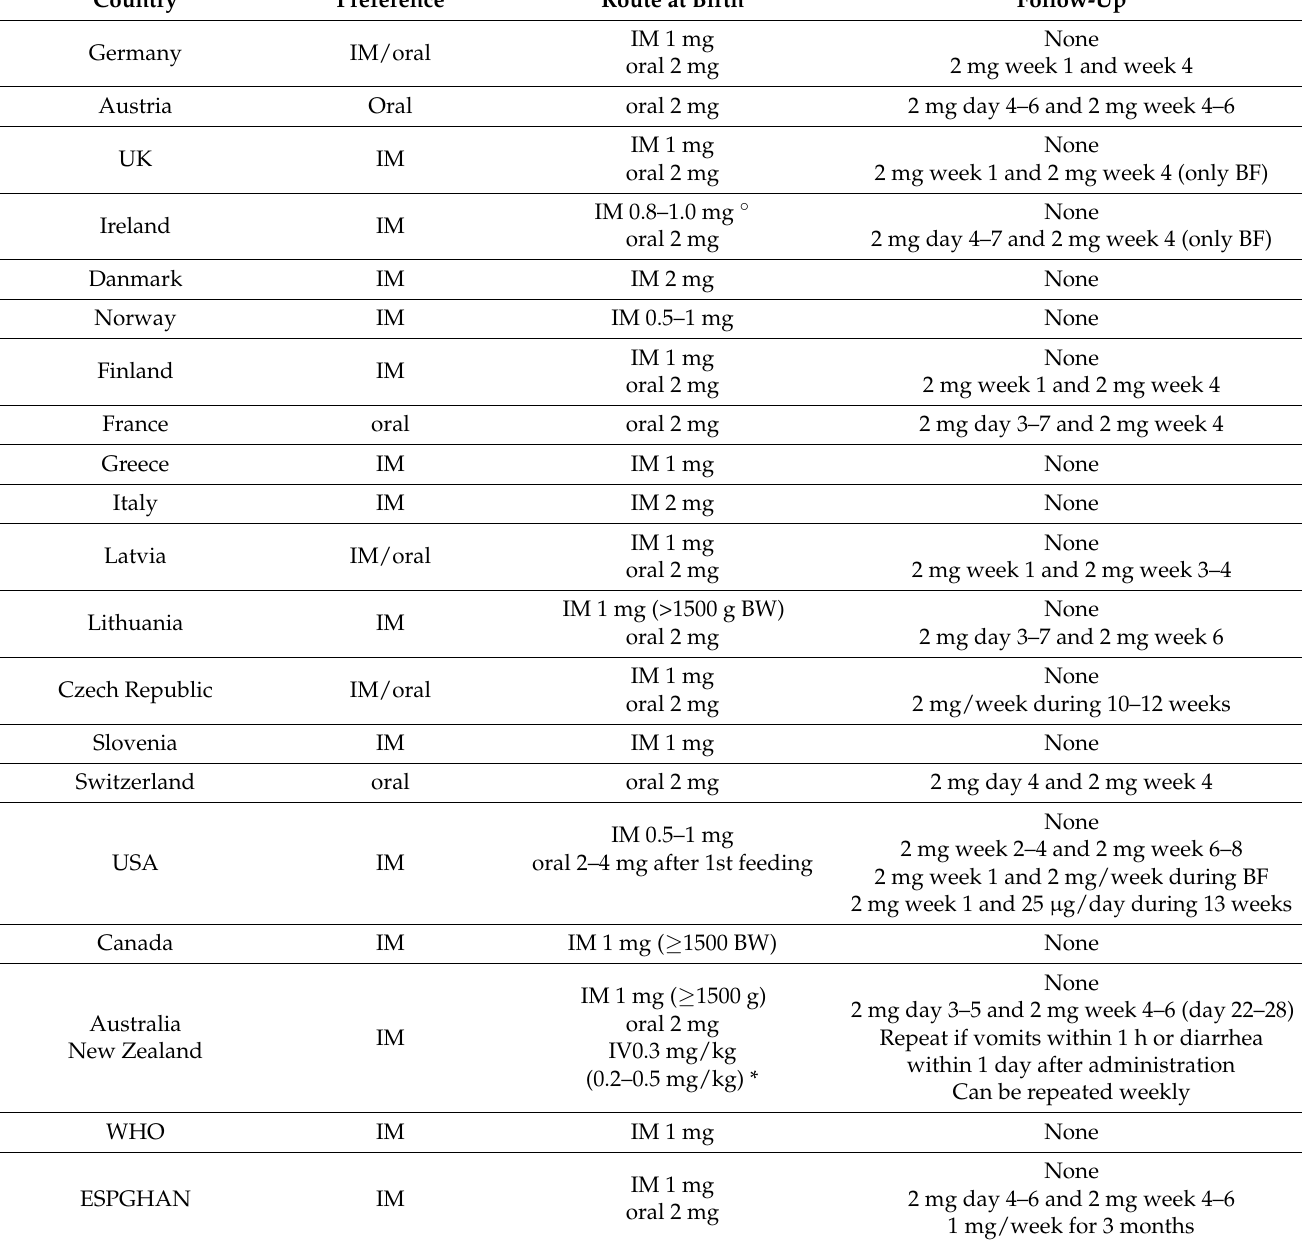
Table 8. Vitamin K recommendation to prevent VKDB in term